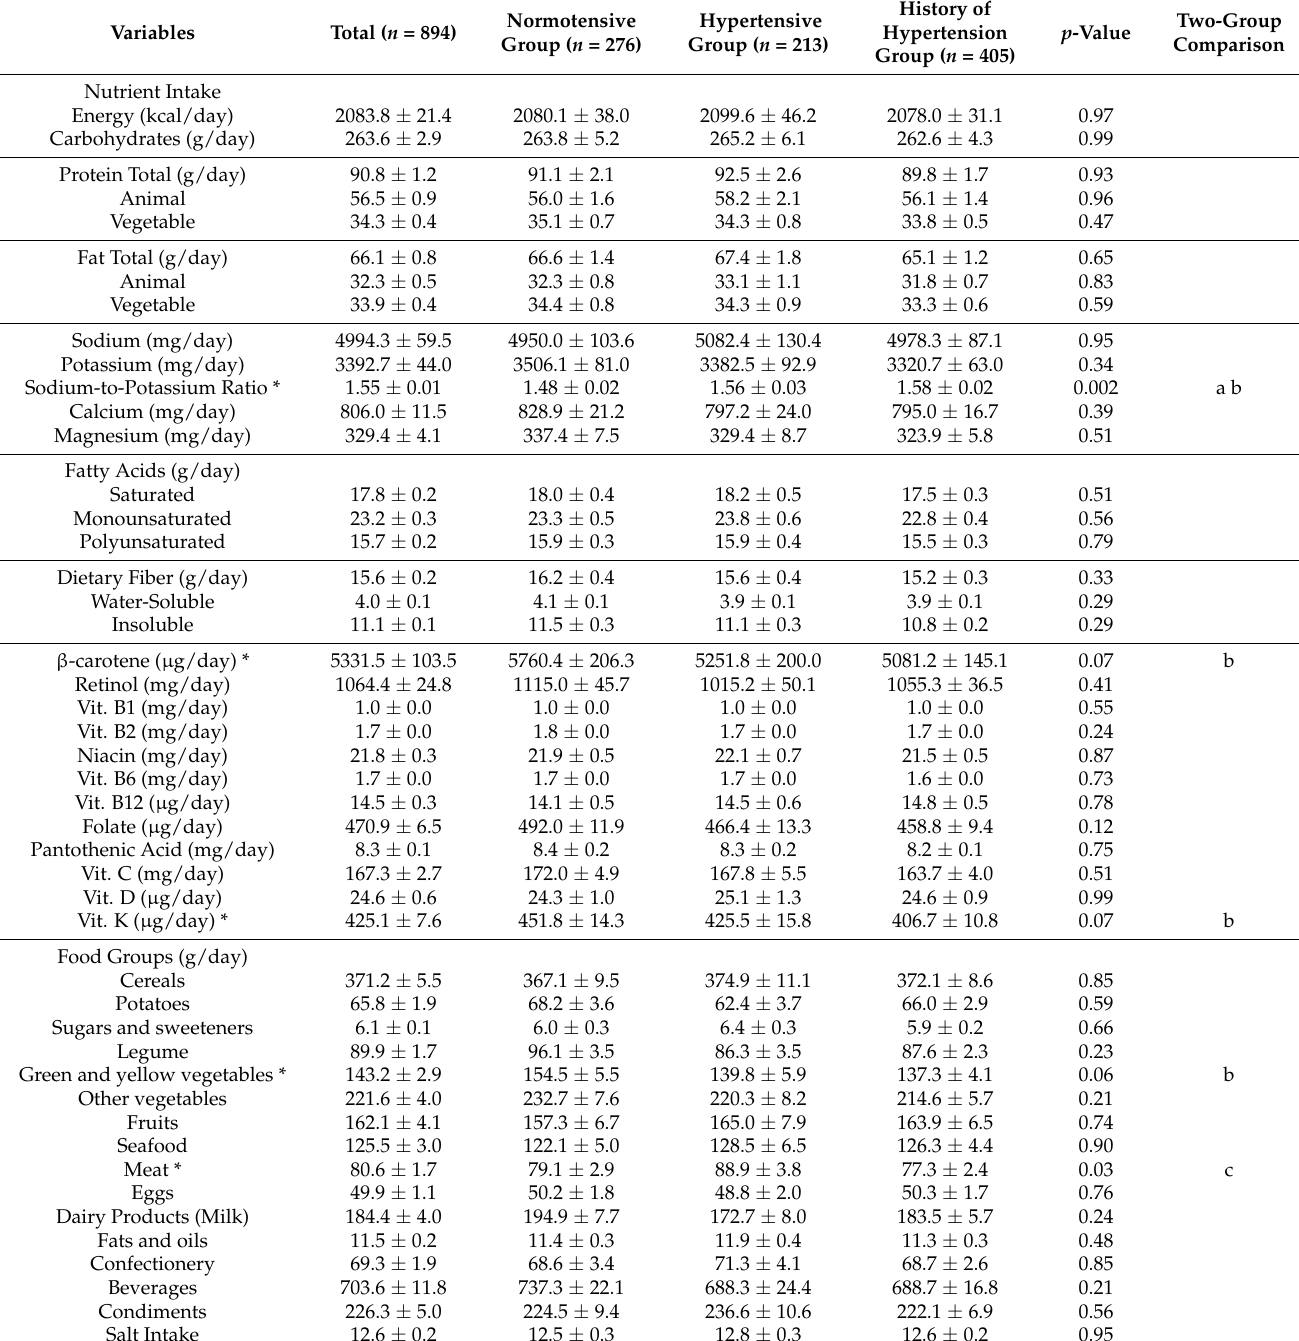
Table 3. Comparison of nutrient and dietary intake among